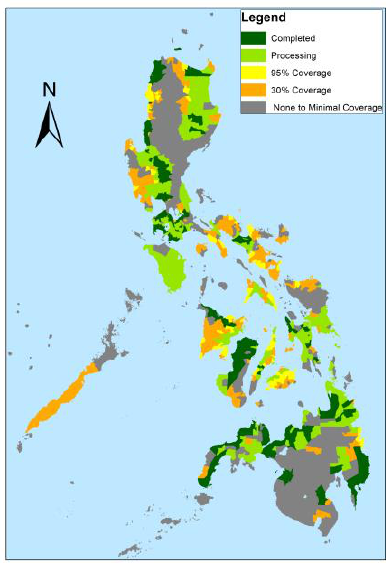
Figure 17. Year 3 vs Year 2